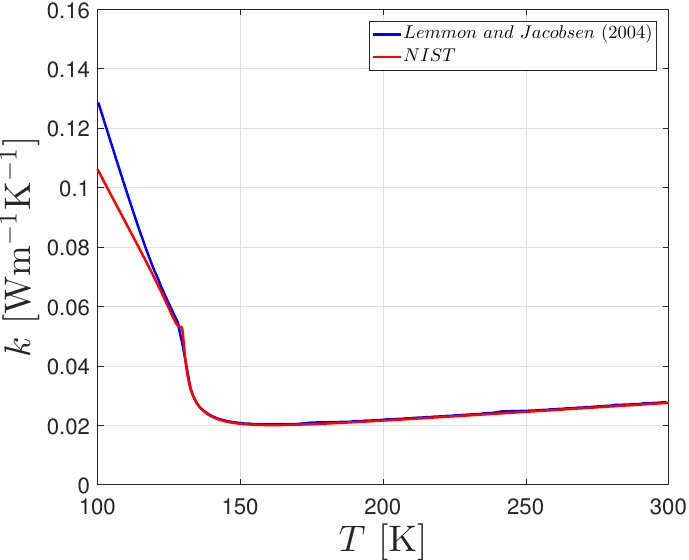
Figure 5. Validation of Lemmon and Jacobsen [57] thermal conductivity model concerning the NIST